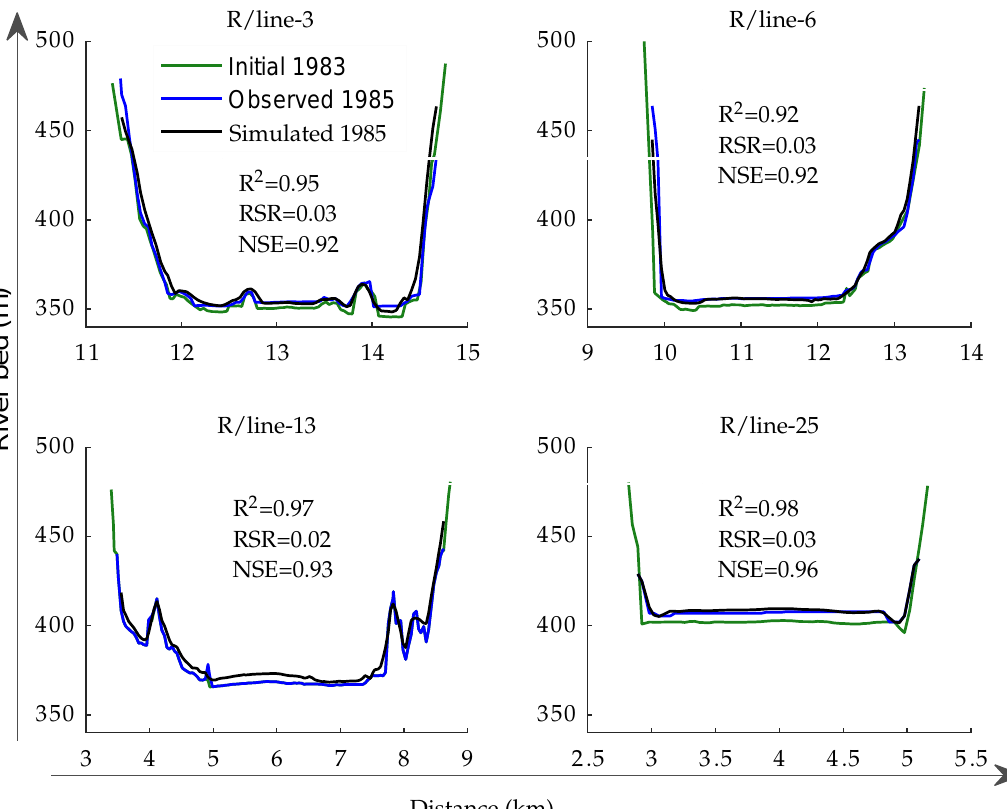
Figure 13. Comparison between measured and simulated river bed at four selected cross sections/range lines (R/line) at the end of calibration process. Measurements start orographically from the left side of the reservoir.